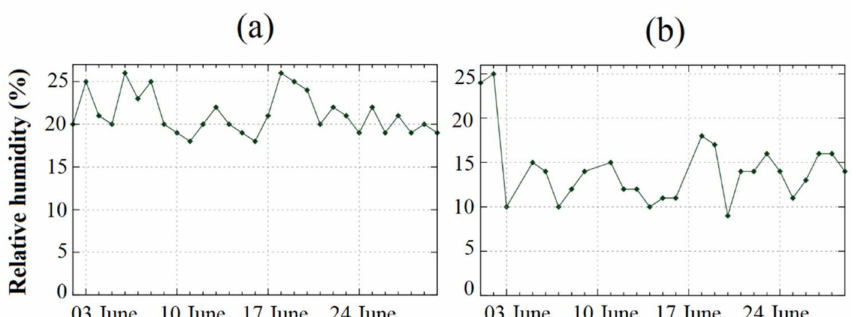
Figure 4. Substantial reduction of relative humidity [%] of the driest month of the year in the zone of the in-situ application (Shiraz) in ten years: ( a ): June of 2010; ( b ): June of 2020 [21].